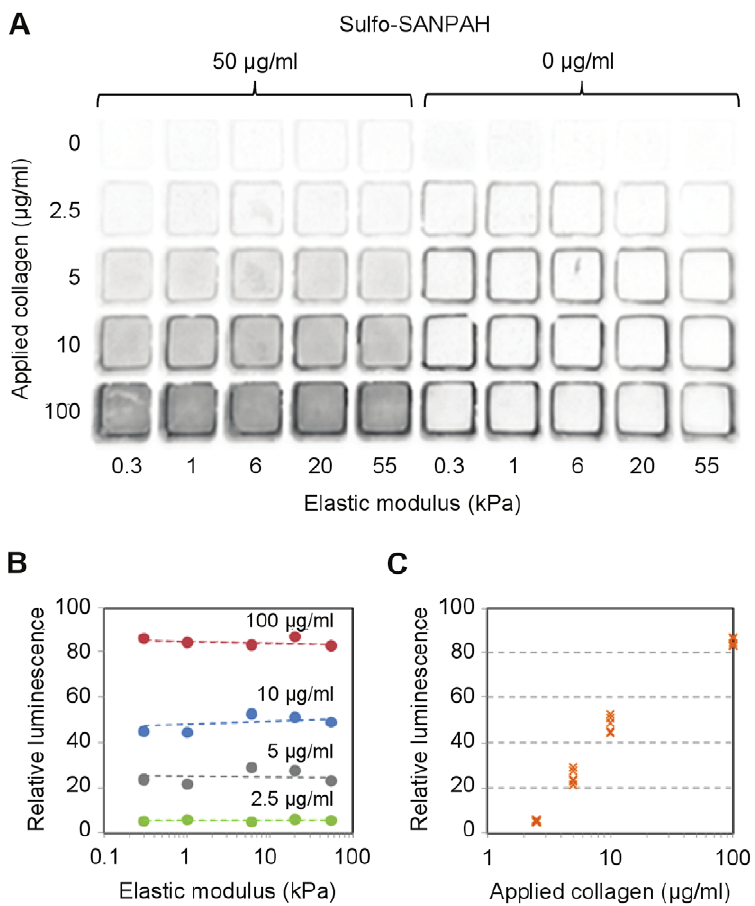
Figure 3. Surface density of collagen across matrix stiffness. (A) Chemiluminescence-based detection of gel-bound collagen. The no sulfo- SANPAH controls assess non-specific adsorption of collagen to the gels. (B) Average pixel intensities of the chemiluminescent signals imaged in (A). (C) Relationship between applied collagen concentration and signal intensity measured across all stiffness conditions in (B).